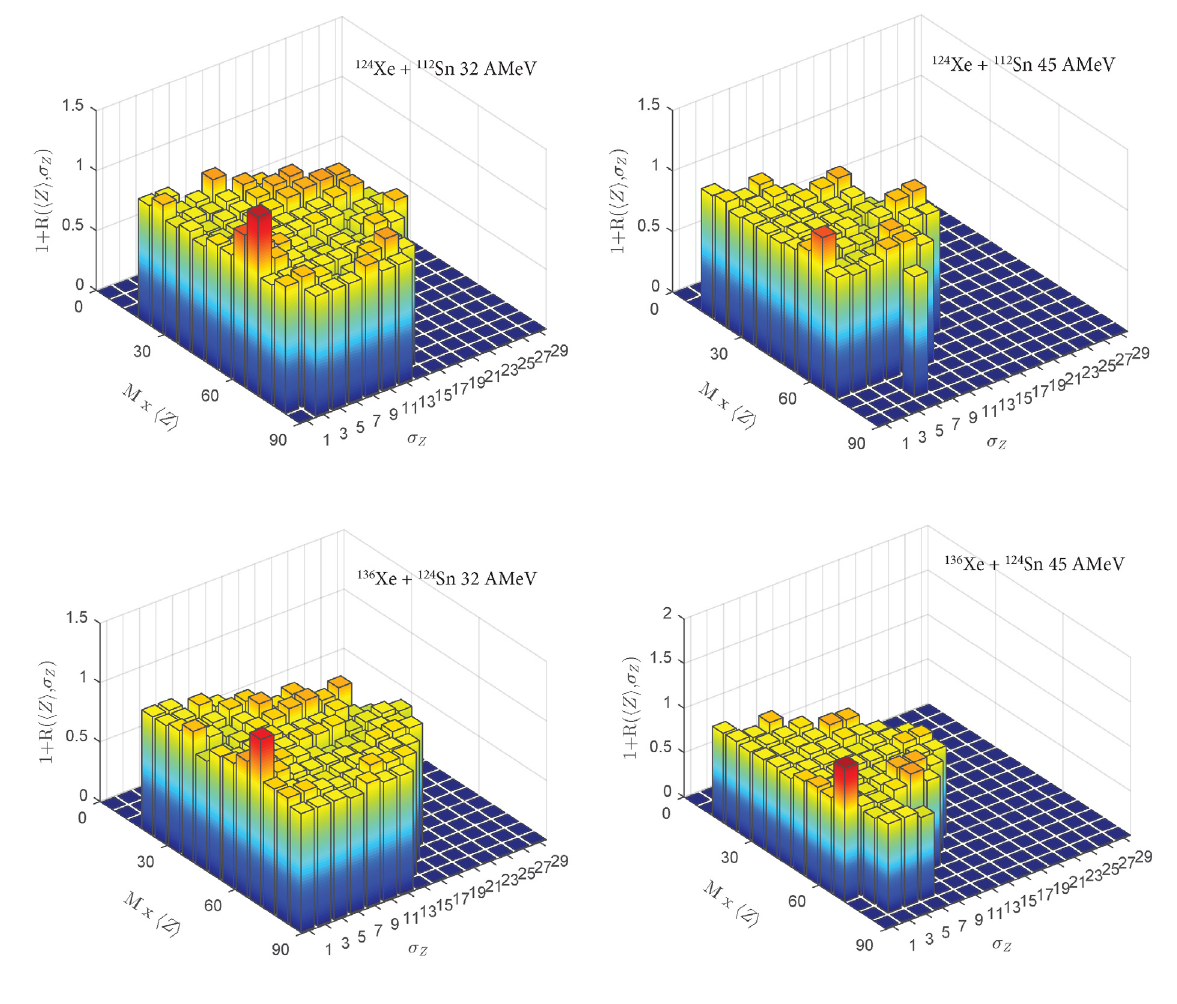
Figure 1. Experimental correlation functions for selected quasifusion events formed in central 124 , 136 Xe + 112 , 124 Sn collisions. Events with fragment multiplicities 3 to 6 are mixed. Correlation functions are calculated for a σ Z bin equal to 2 and a M 6. The color scale for CFs has a maximum value for 1.6 which corresponds to dark red. From